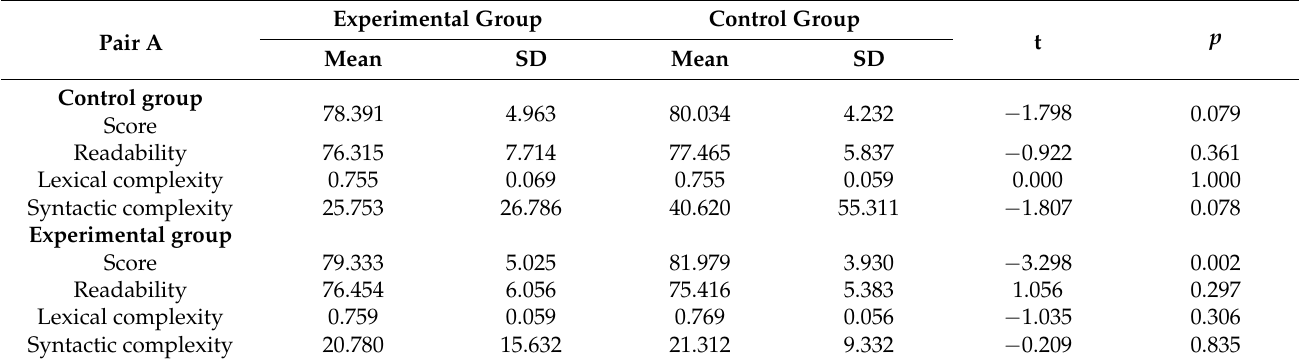
Table 1. Descriptive statistics and t -test results, pretest and posttest.